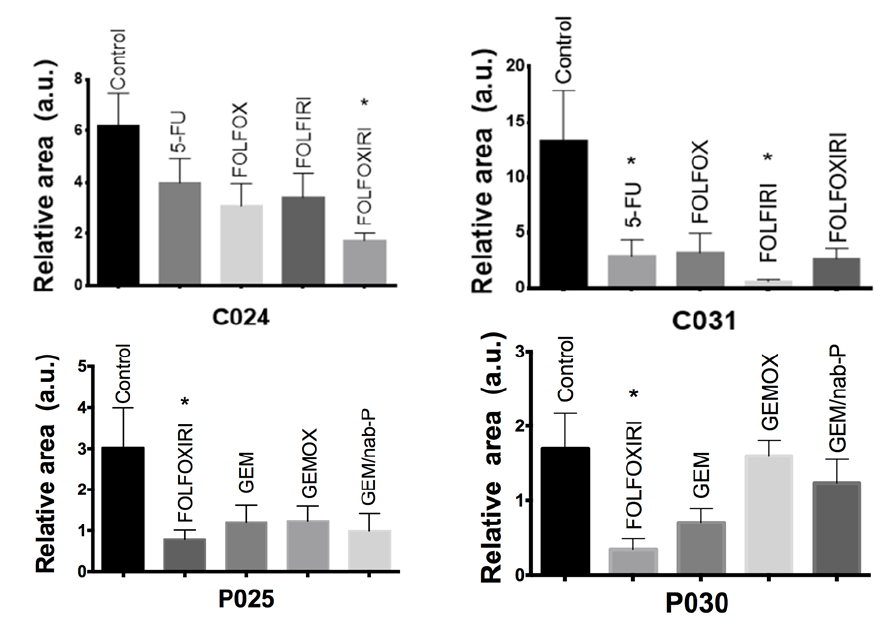
Figure 10. Chemosensitivity assay. Two dpf embryos were injected with fragments of patient tumor tissue and incubated for 48 h with chemotherapy compounds at the ED. Representative cases of colon cancer (C024 and C031 patient-derived xenograft (PDX)) and pancreatic cancer (P025 and P030 PDX) with quantitative analysis of the relative tumor area (2 dpi/2 hpi for colon and 2 dpi/1 dpi for pancreas). All graphs show an increase in the stained area over time in the control group. C024, P025, P030 show a statistically significant regression of the stained area size in the FOLFOXIRI treated group compared with control non-treated xenografts. C031 shows significant stained area reduction in 5-FU and FOLFIRI treated groups compared with control non-treated xenografts. Results are expressed as mean ± SEM and analyzed by 1-way ANOVA followed by Dunnett’s multiple comparisons test. * p < 0.05. C024: n = 5, 7, 8, 9, 5 and C031: n = 8, 7, 5, 5, 4, respectively for control, 5-FU, FOLFOX,